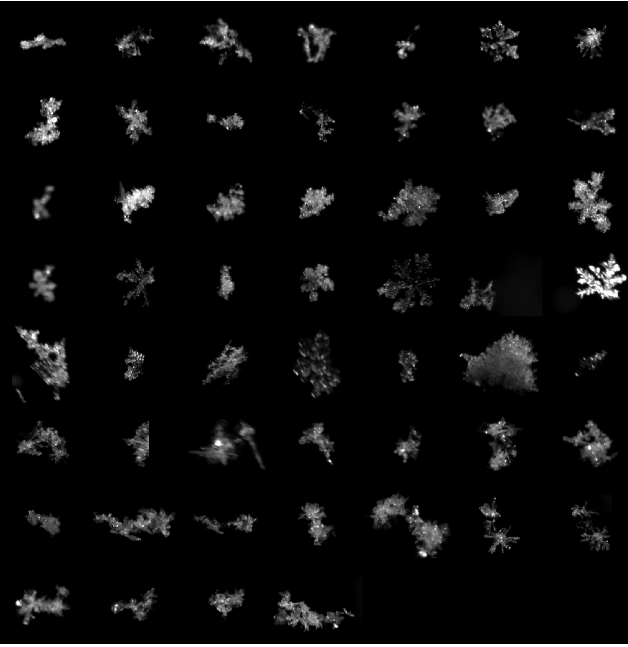
Figure C1. MASC snowflake imagery for 14 January 2020.